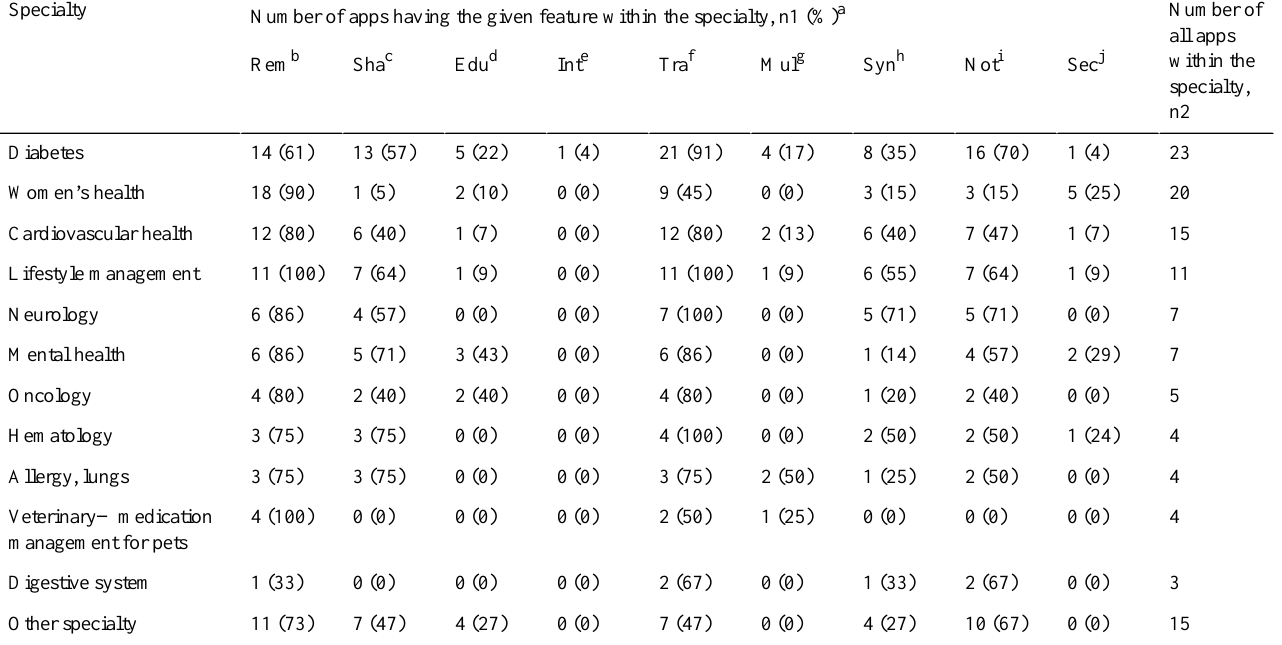
Table 5. Distribution of medication management apps by feature and specialty in medicine.